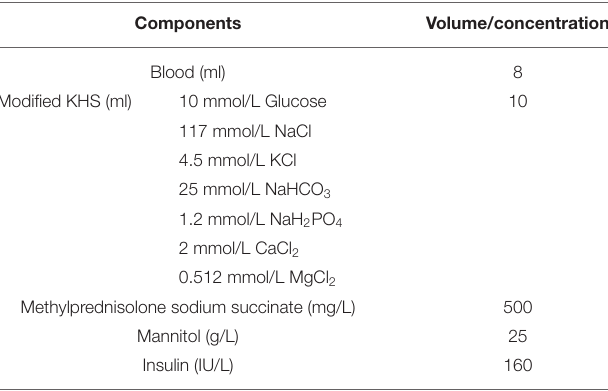
TABLE 1 | The components of perfusate in the ESHP system. Components